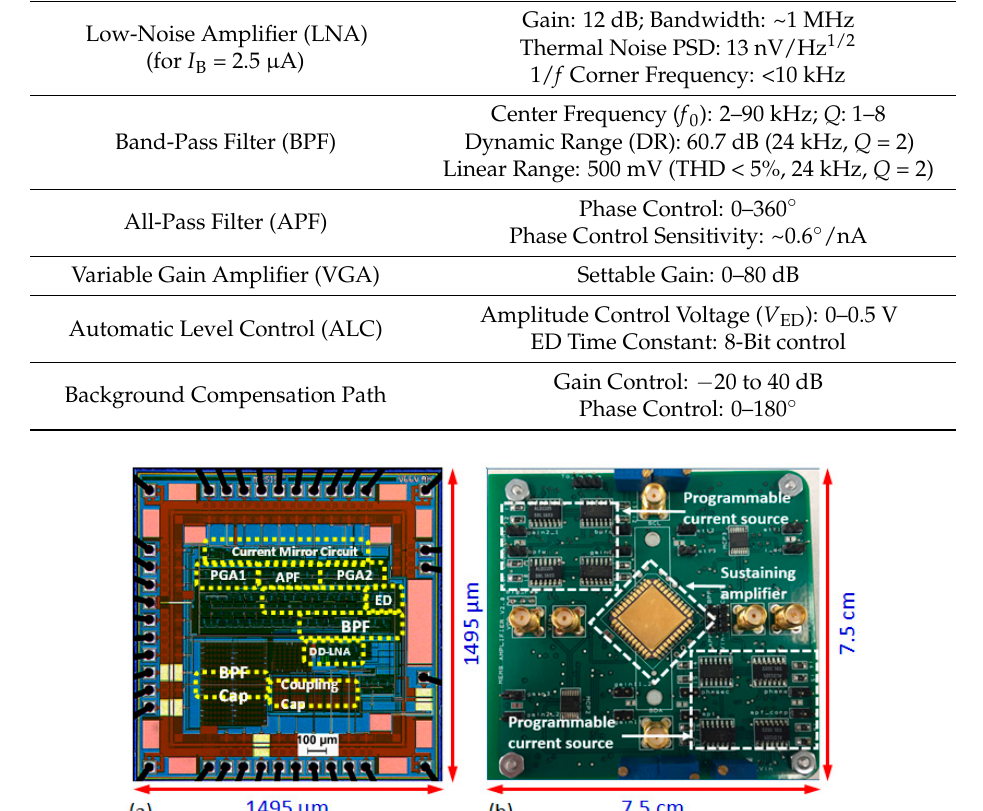
Table 1. Summary of the electrical specifications and performance of the programmable sustaining amplifier.